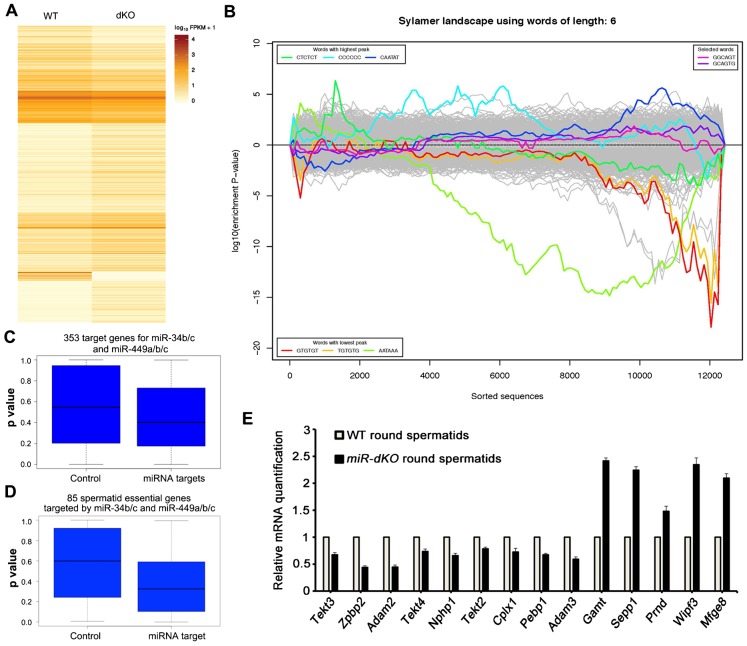
RNA-Seq analyses of the mRNA transcriptomes in WT and miR-dKO round spermatids.(A) Heatmap showing significantly dysregulated genes in miR-dKO round spermatids (compared to WT round spermatids). All 2,386 dysregulated genes are listed in supplementary material Table S4. (B) Sylamer analyses of the dysregulated mRNAs in miR-dKO round spermatids. Since the five miRNAs (miR-34b, miR-34c, miR-449a, miR-449b and miR-449c) share the same seed sequence of “GGCAGUG”, we analyzed two possible 6nt seed sequence combinations, including one with the 1st–6th nt and the other with the 2nd–7th nt (“selected words”). The most enriched 6nt sequences (“words with the highest peak”) were not the seed sequence of the five miRNAs, suggesting that the changes in the mRNA transcriptome are likely caused by secondary effects due to dysregulation of miRNA direct targets in dKO organs. (C) Boxplot of p values of miRNA target and control genes in the RNA-Seq data. To demonstrate that inactivation of the five miRNAs truly affects their target gene expression, the p values (dKO vs. WT) of all 353 miRNA target mRNAs and 353 randomly sampled, non-target mRNAs in the RNA-Seq data were plotted and compared. Paired t test was used and p = 2.351×10−5<0.05. (D) Boxplot of p values of miRNA targets known to be essential for late spermiogenesis and control genes in the RNA-Seq data. To demonstrate that inactivation of the five miRNAs truly affects their target genes known to be required for late spermiogenesis, the p values of all 85 miRNA target mRNAs and the same number of randomly sampled, non-target control mRNAs in the RNA-Seq data (dKO vs. WT) were plotted and compared. Paired t test was used and p = 5.473×10−5<0.05. (E) qPCR validation of 14 dysregulated mRNAs known to be required for late spermiogenesis. Gapdh was used as an internal control. Data are presented as mean±SEM (n = 3).